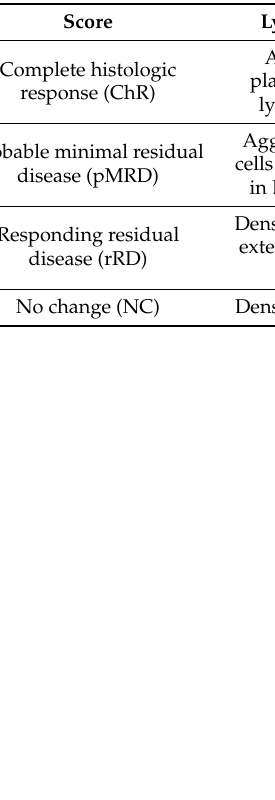
Table 3. GELA histologic grading system for post-treatment evaluation of gastric MALT lymphoma